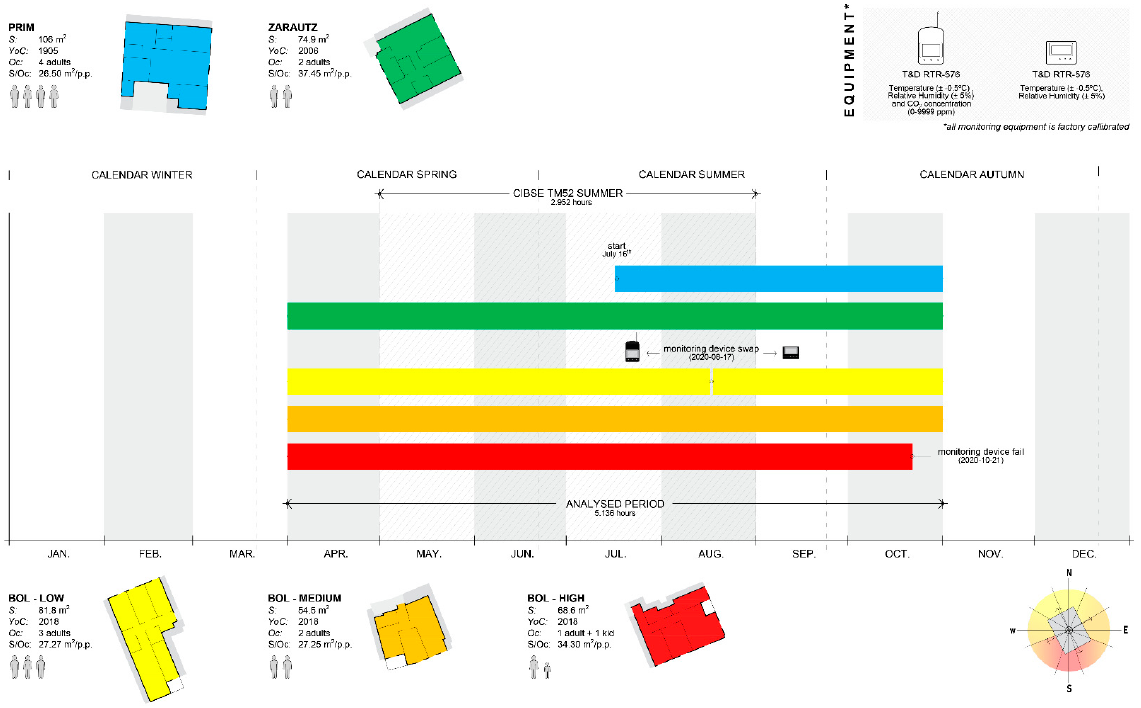
Figure 9. Summer 2020 monitoring campaign overview. Source: authors.